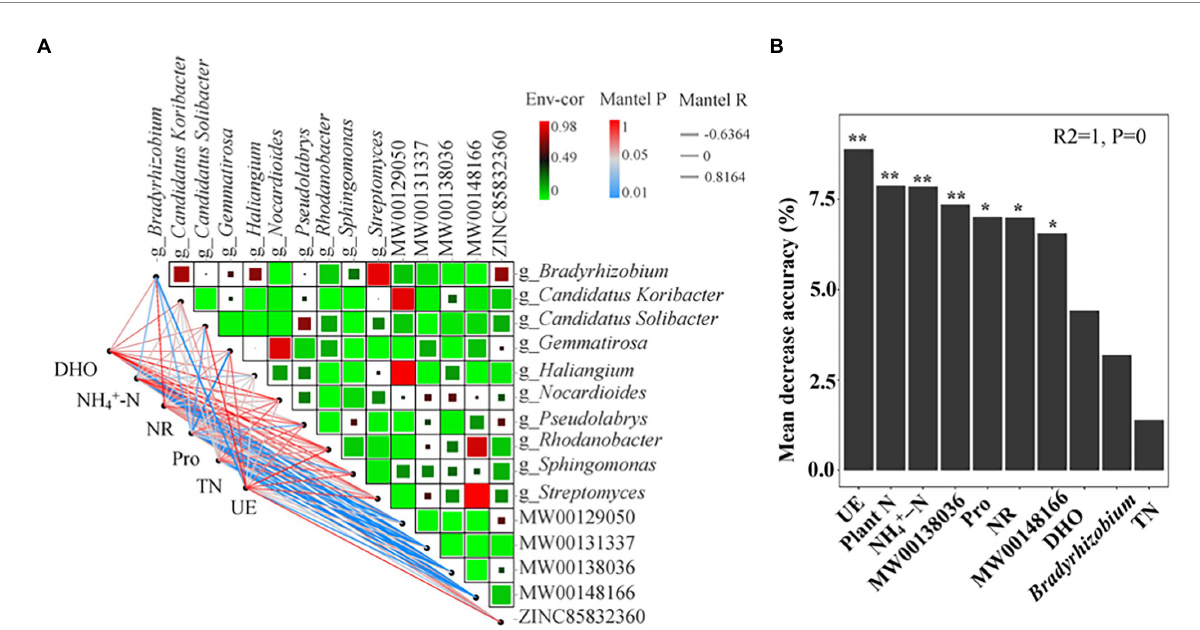
FIGURE 6 Correlations among the soil physicochemical properties, flavonoids root exudates, and bacterial community. (A) A network heatmap of correlations between soil physicochemical properties and root exudates and bacterial communities. (B) Mean predictor importance of factors related to plant production based on random forest analysis. The significance levels of each predictor in the random forest analysis are as follows: * p < 0.05 and ** p < 0.01. Plant N: nitrogen acumulation per plant in maize and peanut; TN: soil total N; NH 4+ –N: soil ammonium N; UE: soil urease; NR: soil nitrate reductase; Pro: soil protease; DHO: soil dehydrogenase; MW00138036: Cyanidin 3-sambubioside 5-glucoside; MW00148166: Cyanidin 3-O-(6-O-p-coumaroyl) glucoside-5-O-glucoside;